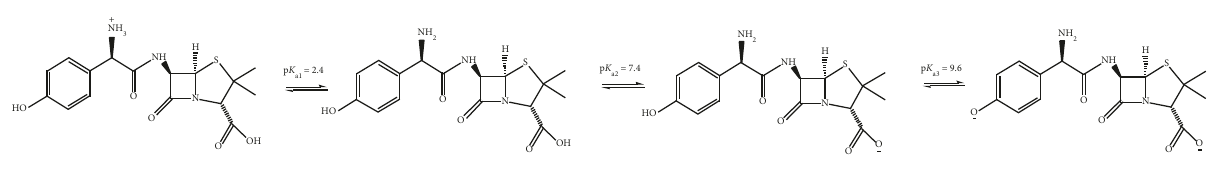
Figure 4: Effects of pH on AMO degradation by TAP. Solid lines represent the pseudo-first-order kinetic model fits. Insert: changes of k at different pH values. Experimental conditions: [AMO] 0 � 0.1mM; [PS] 0 � 10mM; T � 50 ° C; reaction time � 330 min.